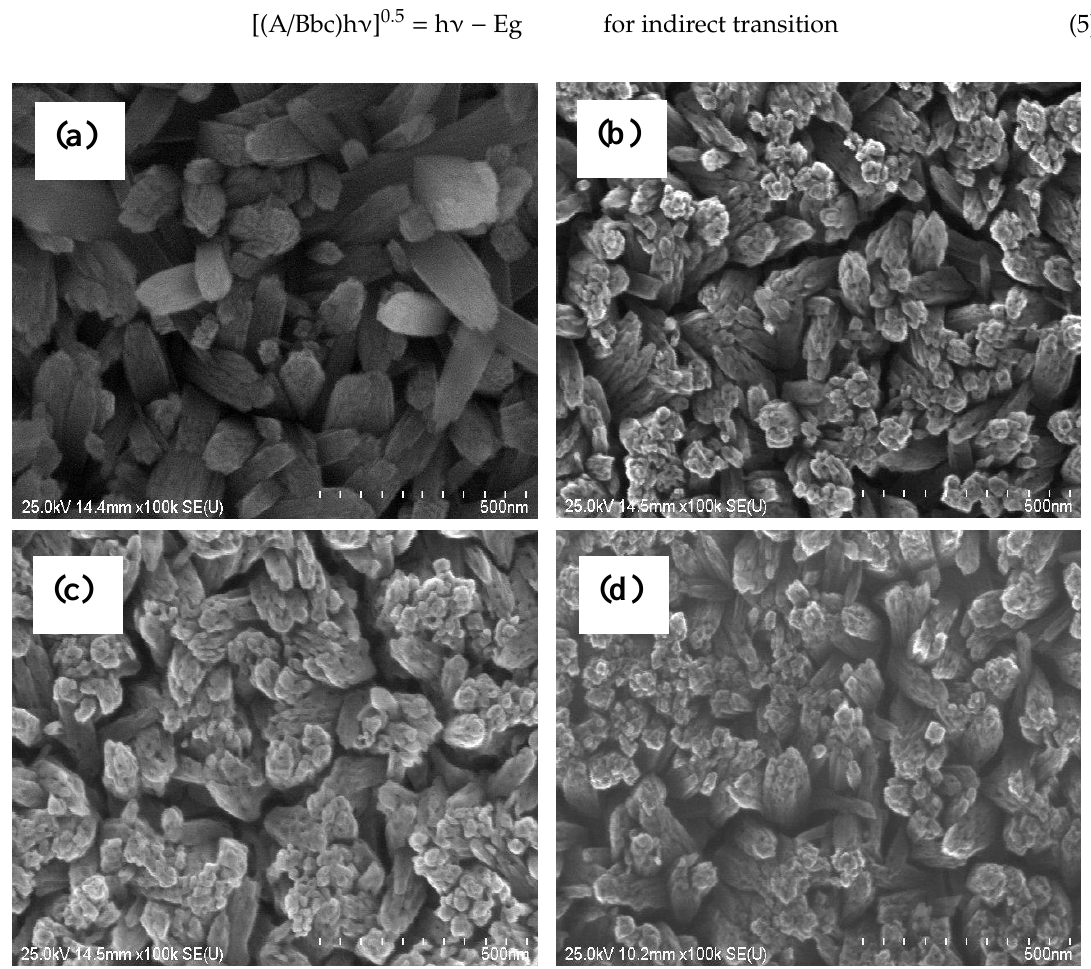
Figure 5. Scanning electron microscope (SEM) images of the samples: ( a ) precursor β-FeOOH; ( b ) undoped α-Fe 2 O 3 ; ( c ) Co -doped α-Fe 2 O 3 ; ( d ) Ni-doped α-Fe 2 O 3 . Eg: energy gap in eV between a conduction band and a valence band λ : wavelength in